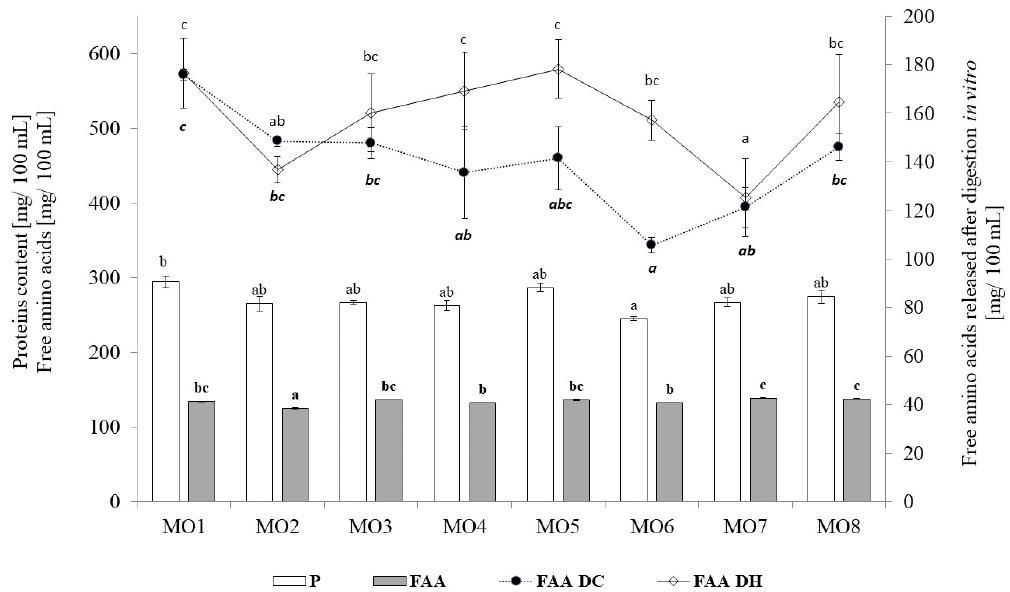
Figure 3. Total starch, resistant starch, and free reducing sugars, in the powders and after digestion